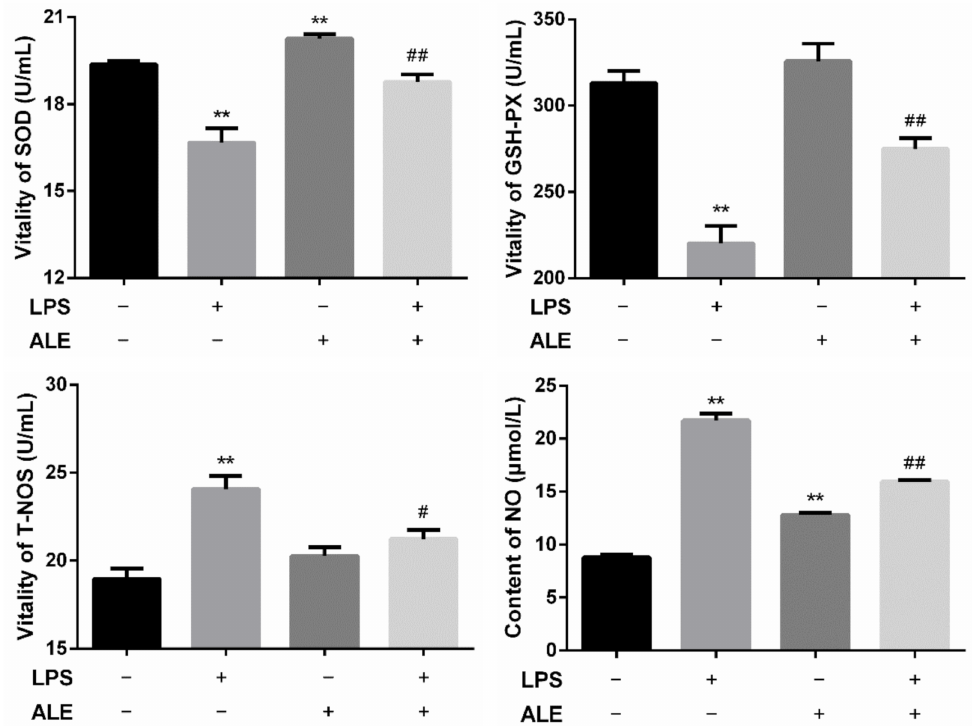
Figure 4. Regulation of ALE on serum oxidation indexes in LPS-induced mice. ** p < 0.01 vs. control group; # p < 0.05, ## p < 0.01 vs. LPS